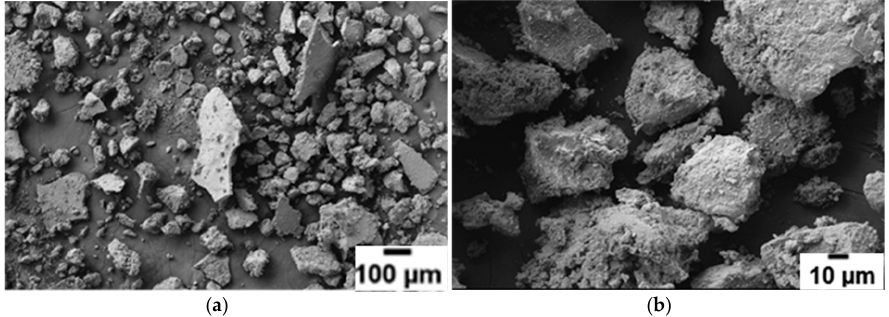
Figure 7. Scanning electron micrographs (SEM) of the 1 h BM (2NaBH 4 + MnCl 2 ) sample, subsequently filtered/extracted at 42 °C. ( a ) Low and ( b ) high magnification.